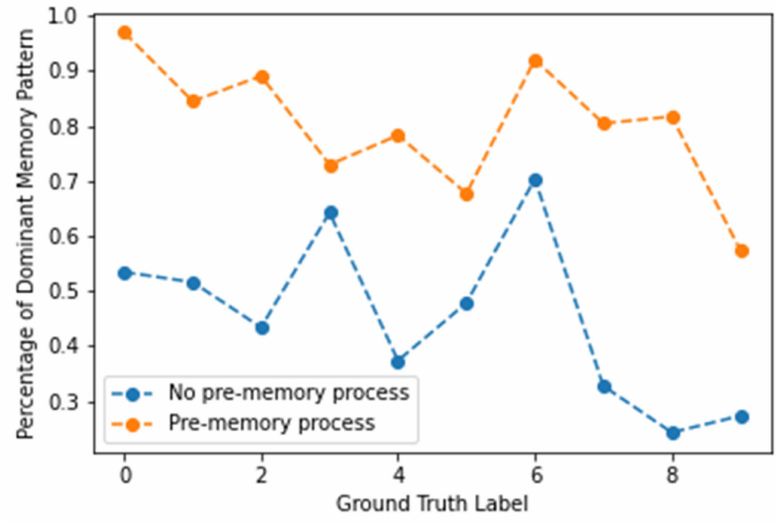
Figure 26. Percentage of dominant memory pattern for each ground-truth label in SDR 20% overlap as a similarity